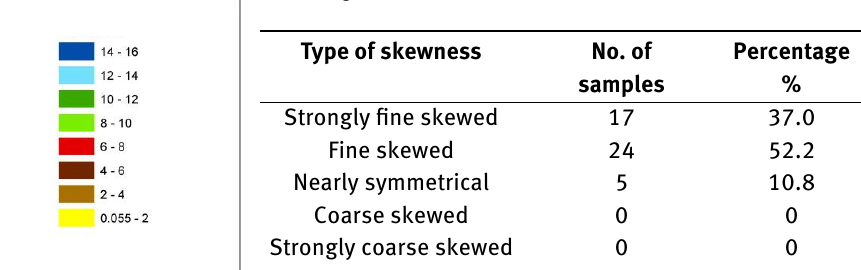
Table 6: Skewness of sediment samples from the bed of River Tigris within Baghdad.